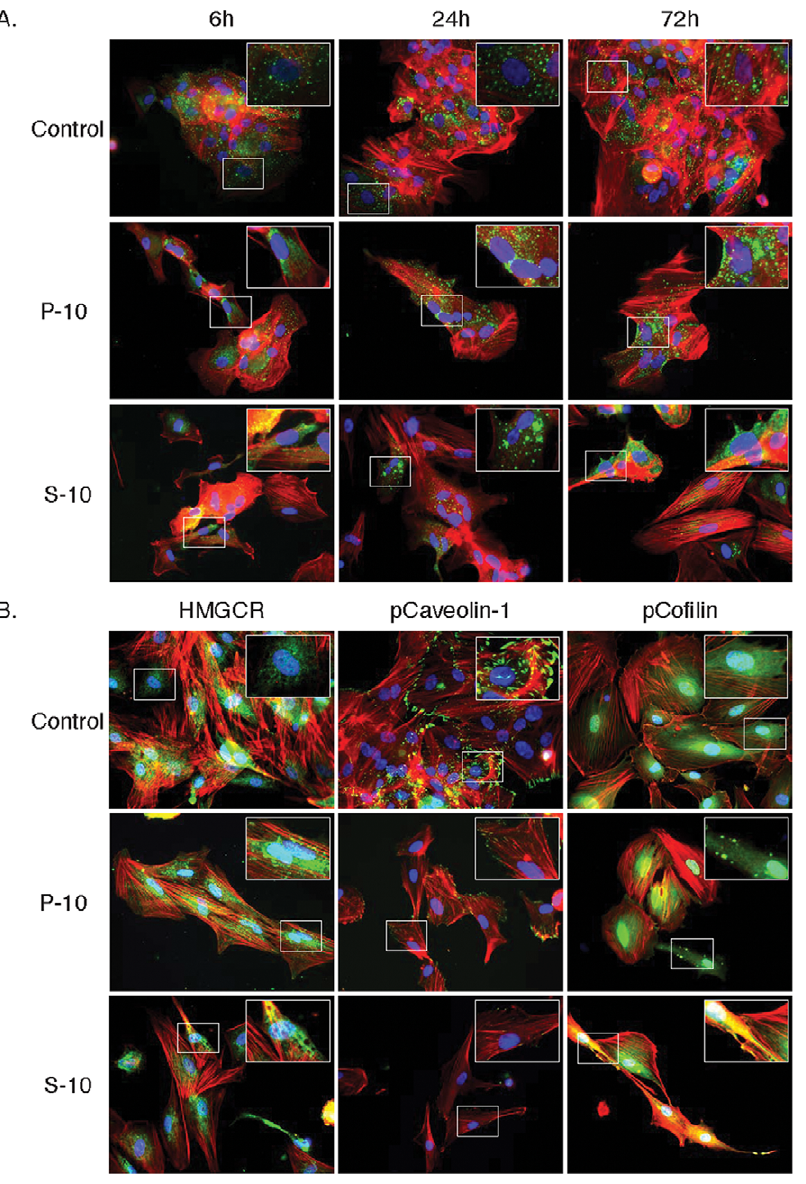
Figure 6. OATP and HMGCR redistribution, loss of p-caveolin and clustering of p-cofilin in statin treated cells. A) OATP immunofluorescent labeling (green) is observed diffusely distributed over the surface of untreated hepatocytes but becomes more perinuclear in cells treated with hydrophilic-pravastatin or lipophilic-simvastatin. Cells were counterstained for actin using alexa-594-phalloidin (red) and nuclear DNA using DAPI (blue). Actin redistribution occurs in conjunction with cellular elongation. B) HMGCR immunofluorescent labeling (left column, green) was diffusely distributed within untreated hepatocytes but became more perinuclear in cells treated with hydrophilic-pravastatin or lipophilic- simvastatin. Cells were counterstained for actin using alexa-594-phalloidin (red) and nuclear DNA using DAPI (blue). P-Tyr14-caveolin (green) expression was lost following statin treatment (middle column). P-Ser3-cofilin (green) formed clusters following statin treatment (right column).